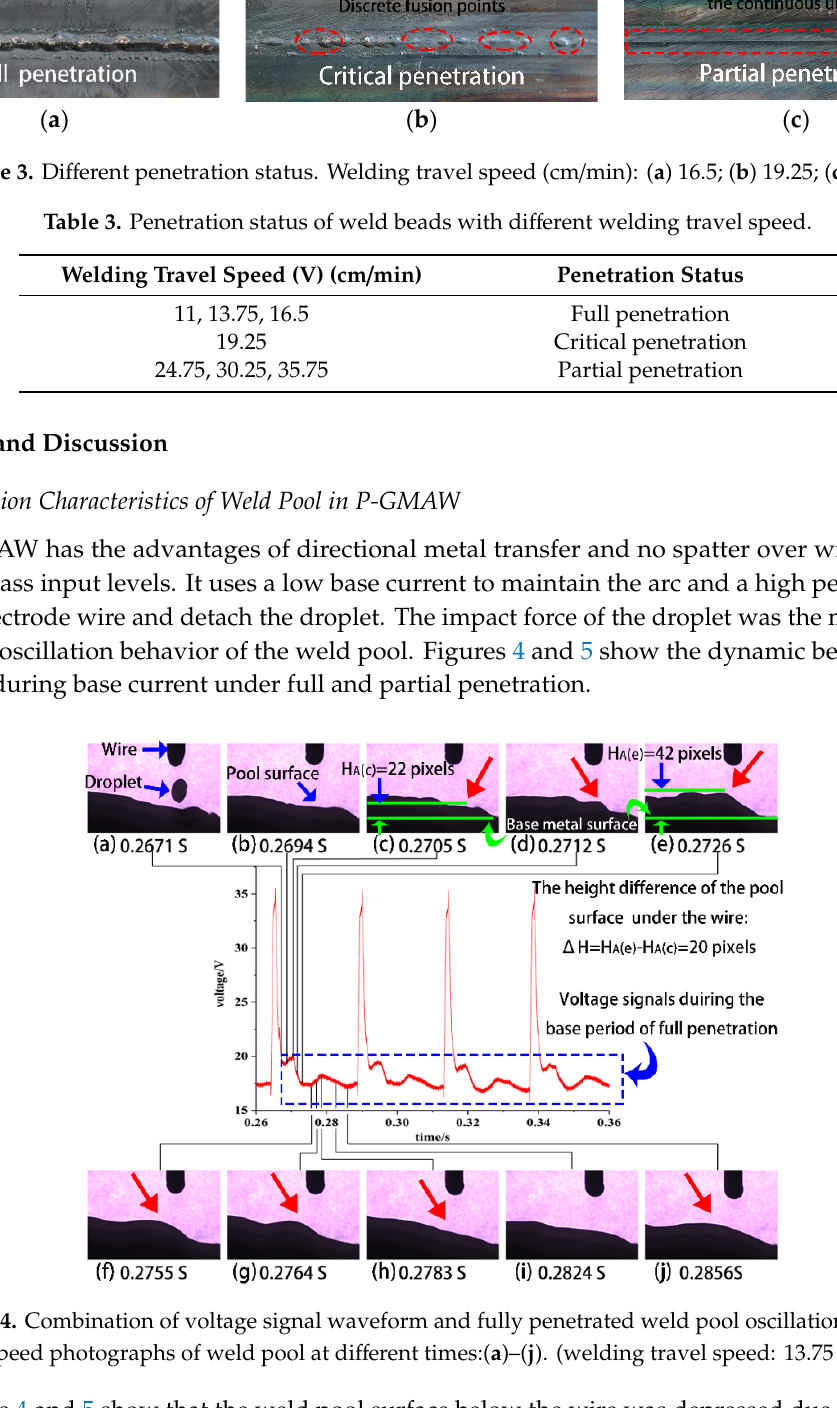
Figure 5. Combination of voltage signal waveform and partly penetrated weld pool oscillation process. (welding travel speed: 24.75 cm/min). Figures 4 and 5 show that the weld pool surface below the wire was depressed due to the impact of the droplet, then the surface of the weld pool bounces to form waves. The red arrow of Figures 4 and 5 show the positions of wave peaks on the weld pool surface at different times. Under the same pulse parameters, the impacts of the droplets on the pool were similar [15], while the fully penetrated weld pool and the partly penetrated weld pool have a distinct difference in the oscillation behavior. Compared with the oscillation amplitude of the partial penetrated pool (according to the ΔH = 20 pixels in Figure 4), the oscillation amplitude of the fully penetrated weld pool was larger (according to the ΔH = 10 pixels in Figure 5). The difference in the oscillation behavior of the weld pool leads to the difference in the arc length, which resulted the difference from the voltage signals (as shown from the blue boxes in Figures 4 and 5).